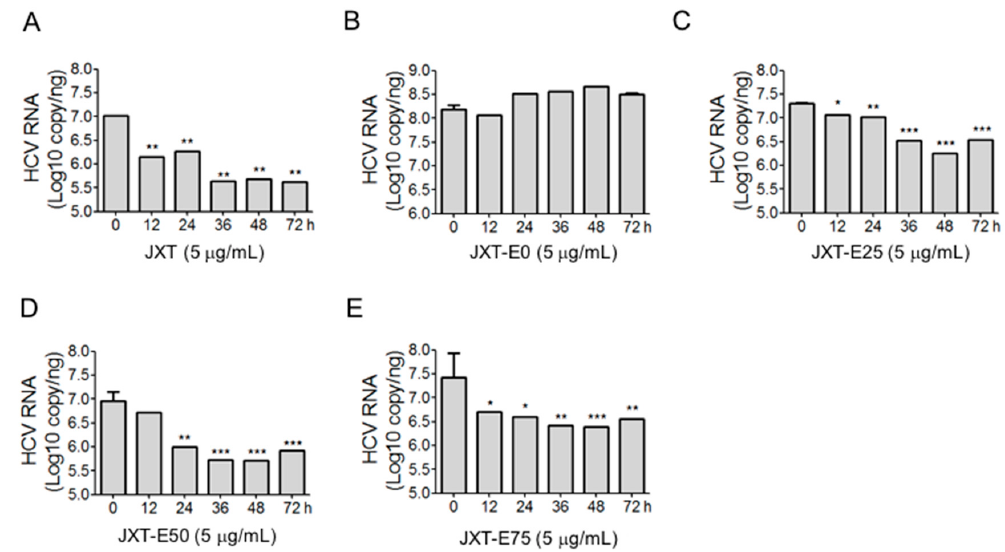
Figure 4. Effect of ( A ) JXT; ( B ) JXT-E0; ( C ) JXT-E25; ( D ) JXT-E50; and ( E ) JXT-E75 extracts on HCV RNA levels. Huh-luc/neo-ET cells were seeded in a 6-well plate and treated with 5 μ g/mL of JXT fractions for different time periods. At the end of the treatment, RNA was extracted with Trizol and converted to cDNA. The level of HCV RNA was determined through real-time PCR. The expression level of 18S rRNA was used as a control. The absolute copy number of HCV RNA was determined with the standard curve generated by using the linearized pFK-I389/NS3-3 ′ plasmid. The results were obtained from three independent experiments and presented as mean ± SD (* p < 0.05, ** p < 0.01, *** p < 0.001 compared with DMSO control). Some of the error bars were too small to be seen.